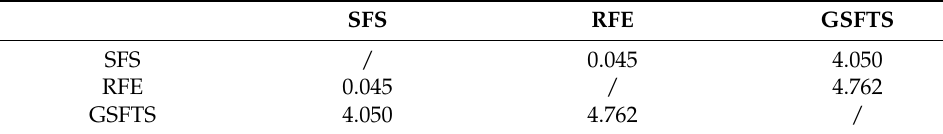
Table 10. McNemar statistic matrix for different feature selection methods.